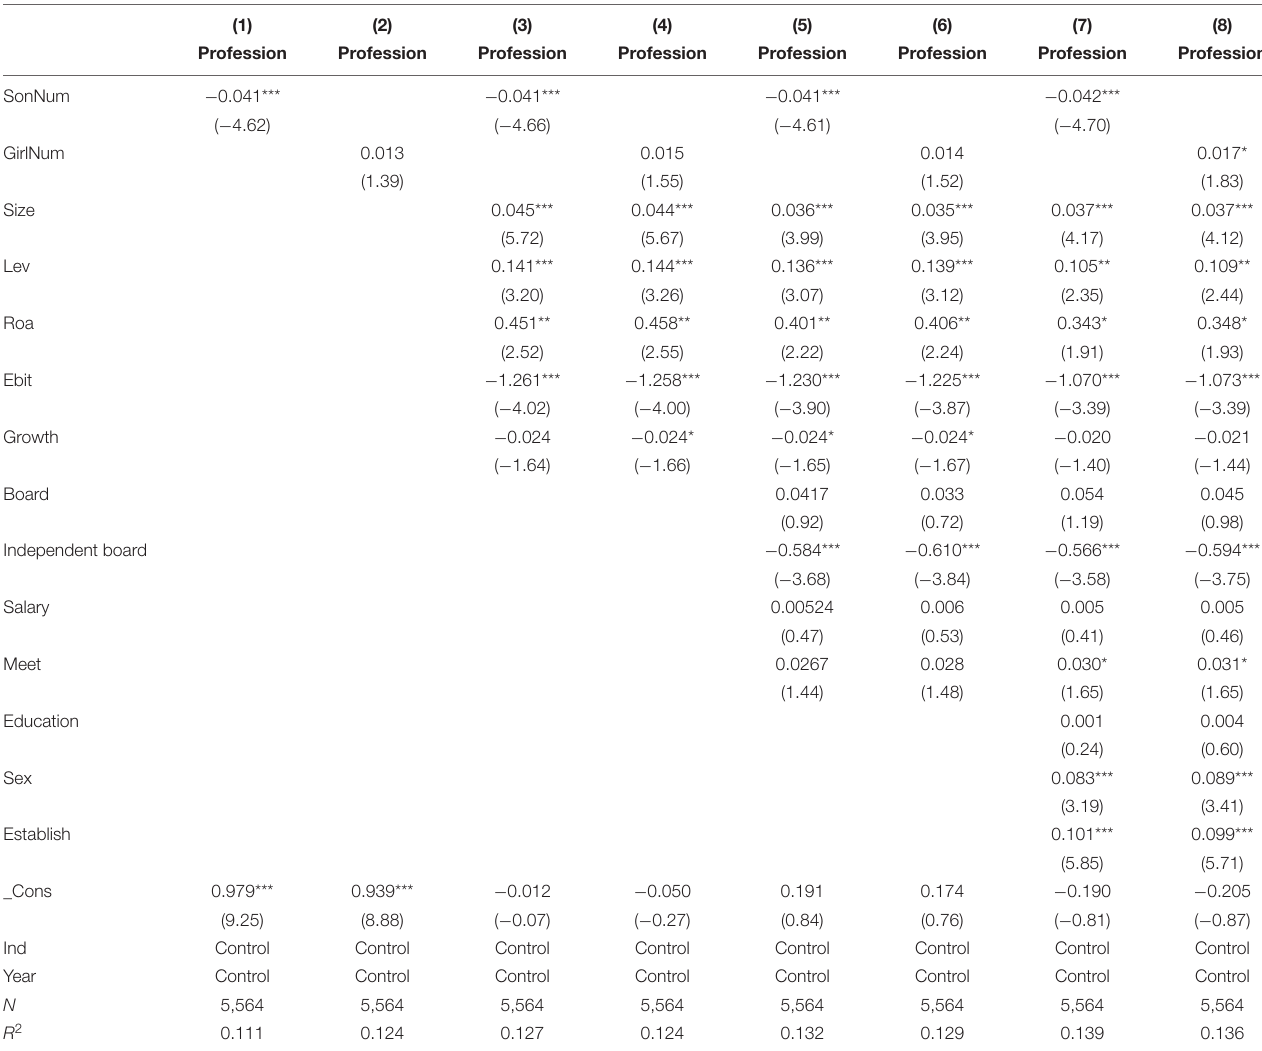
TABLE 10 | Number of sons, daughters, and